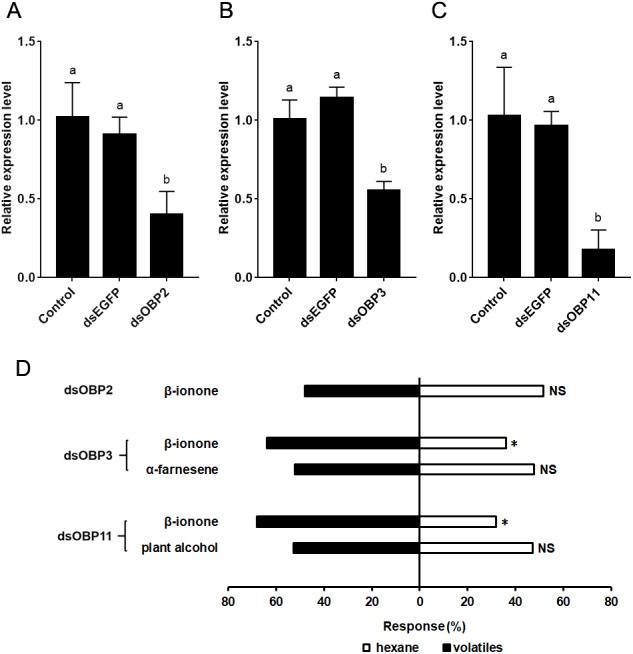
The relative expression levels of SfurOBPs in S. furcifera and behavioral responses of dsRNA treated S. furcifera in the Y-tube olfactometer bioassay.(A), (B) and (C) The mRNA levels of SfurOBP2, SfurOBP3 and SfurOBP11 in S. furcifera were measured at 24 h after injection of dsRNA. The bars represent mean ± SD of 3 biological replicates, different letters above bars indicate significant differences (one-way ANOVA, P < 0.05). (D) Behavioral responses of S. furcufera for rice plant volatiles. A Chi-squared test was used to determine the difference of the insects choosing an odor, with the following levels of significance: *P < 0.05. NS indicates no significant difference.